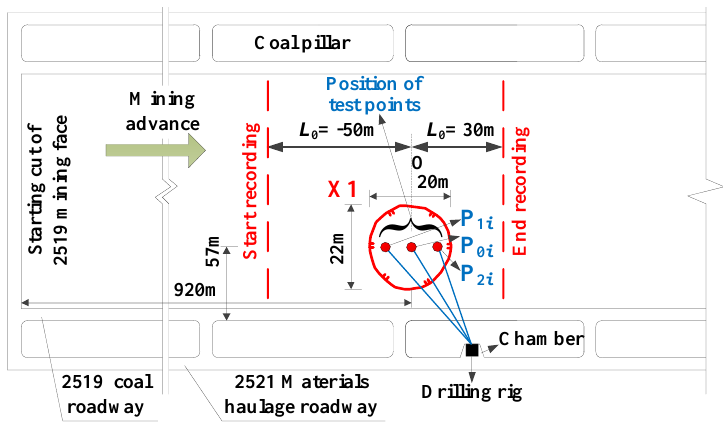
Figure 4. The location of the test points (top view). Table 1. Connectivity experiment between P 01 and P 02 .